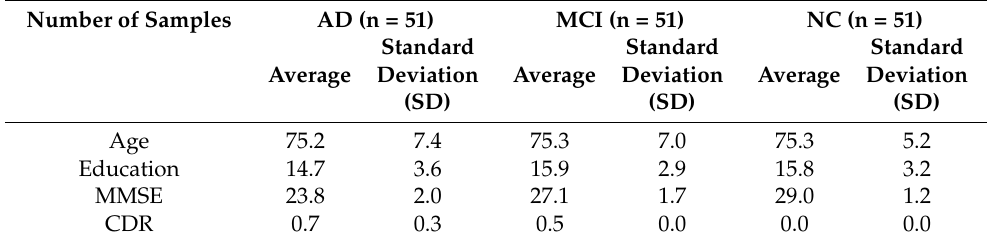
Table 1. The demographic of the rs-fMRI subjects for our proposed